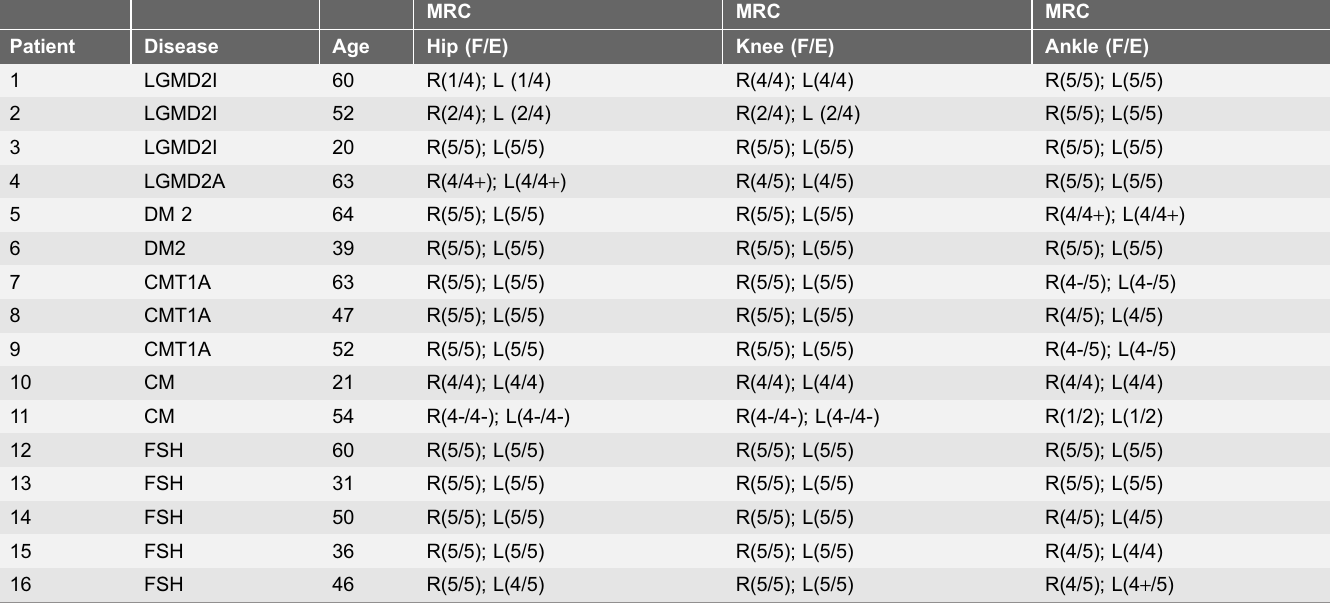
Table 1. Gene mutations and muscle strength in 16 patients with neuromuscular